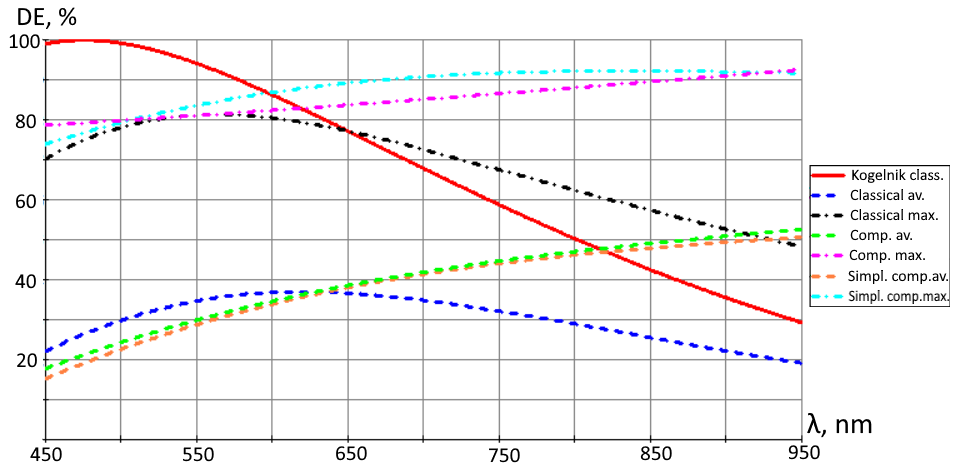
Figure 11. Comparison of the DE spectral dependence in the FoV center.